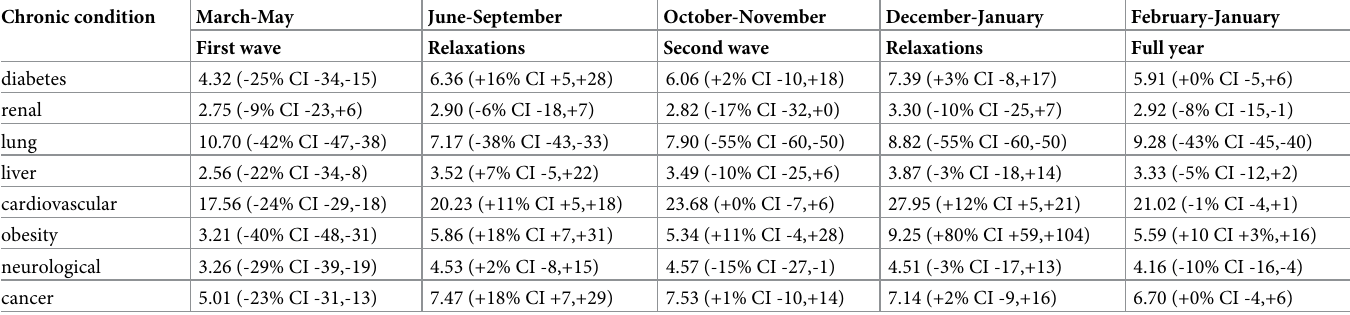
Table 1. Average number of diagnoses per 1,000 patient years during the first year of the Corona pandemic and percentage change in diagnose incidence relative to the previous two years along with 95% confidence intervals. Results are stratified by calendar period and diagnoses group. Chronic